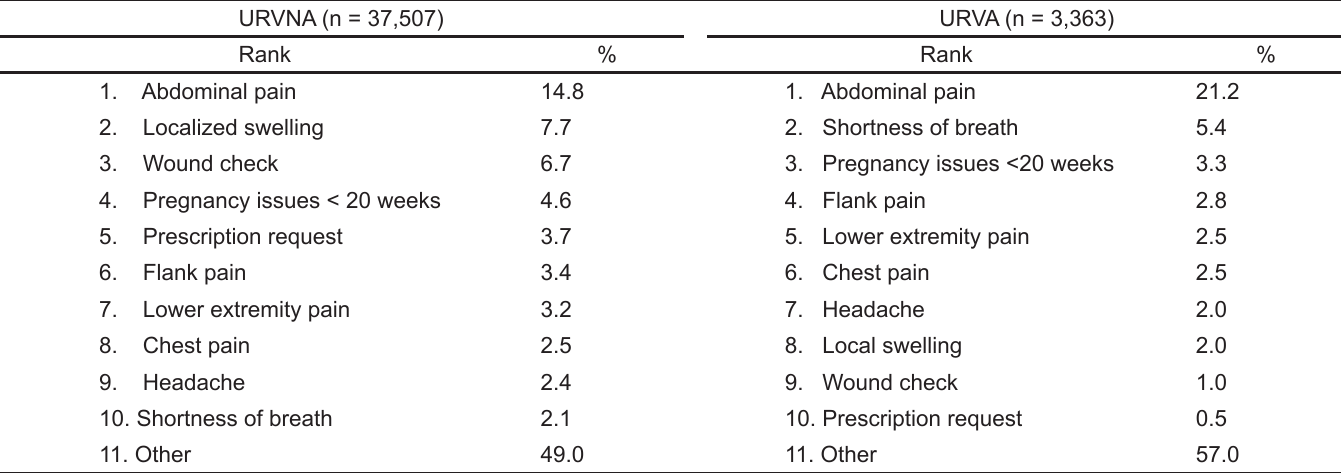
Table 3. Frequent presenting complaints in URVA and URVNA